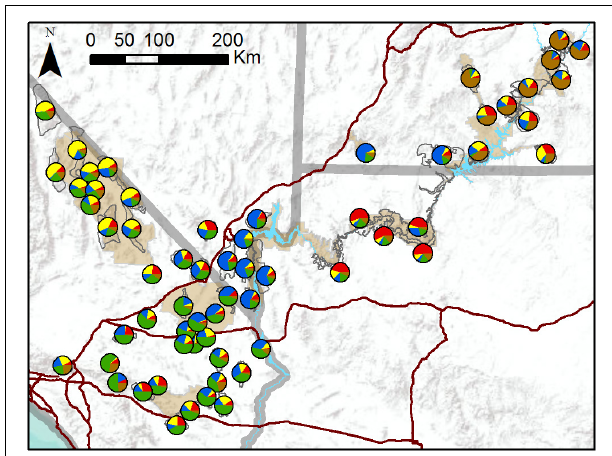
FIGURE 3 | Map of population assignments to five genetic clusters from TESS3 analysis of all 62 desert bighorn sheep populations in study area. Major water barriers and interstate highways are shown in light blue and dark red, respectively, tan shaded areas show National Park Service units; and hollow gray polygons show habitat polygons associated with